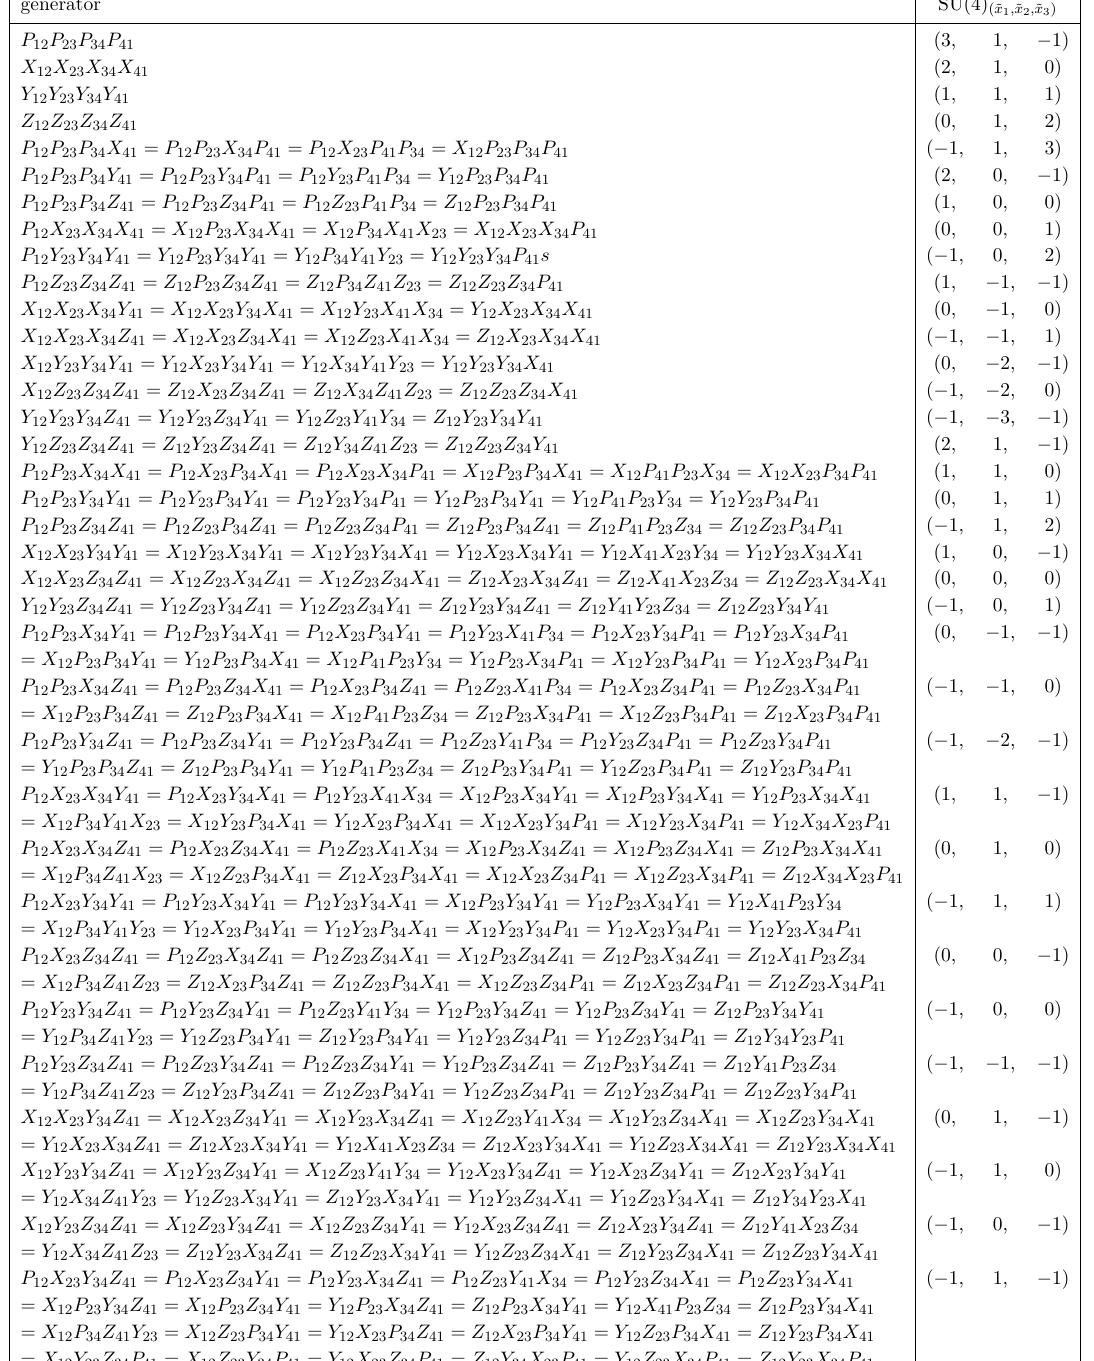
Table 8 . The generators in terms of bifundamental chiral fields for Model 1.